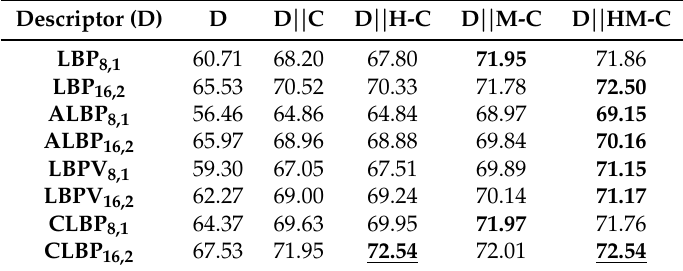
Table 5. Hit rates (in %) obtained with a given LBP-based descriptor (LBP, ALBP, LBPV and CLBP) and the concatenations of the descriptor with CLOSIB variants. The best results for each LBP-based descriptor are highlighted in bold. The best overall results are underlined. D stands for Descriptor and C for